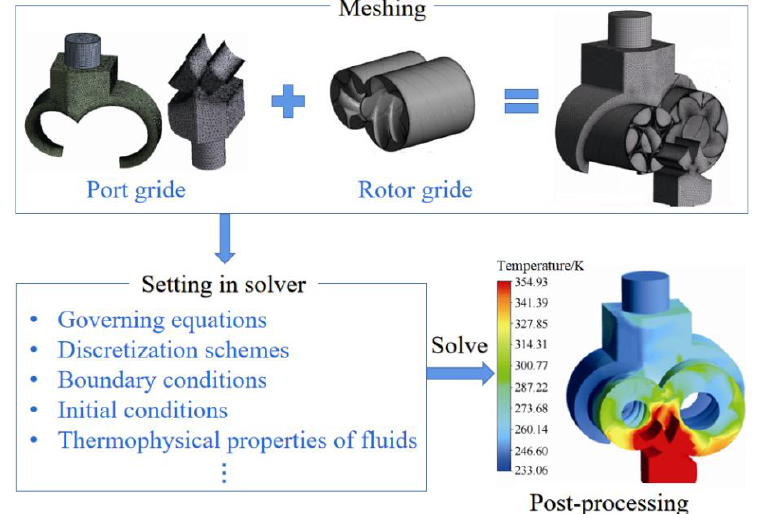
Figure 5. Flowchart diagram of CFD modelling of twin-screw machines.